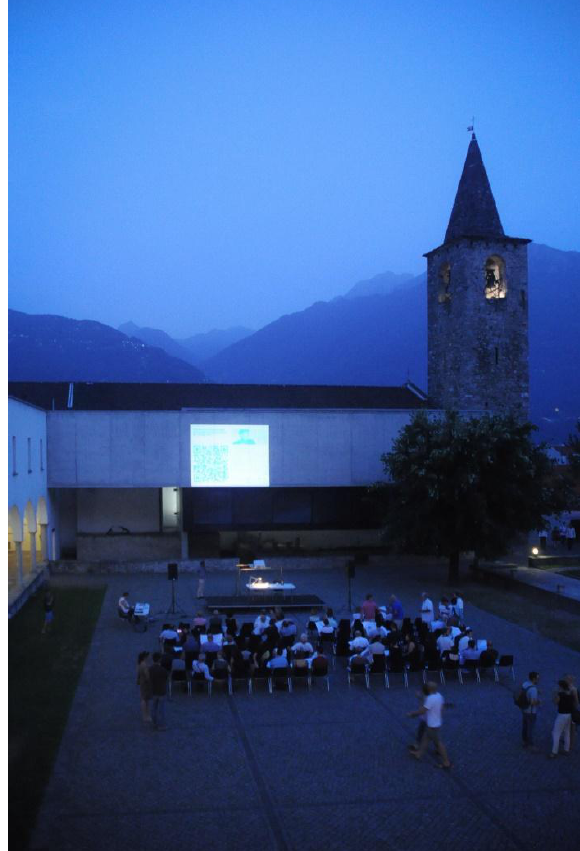
Figure 4. Public event during the design seminar gathering specialists and the local community. Source: Author.